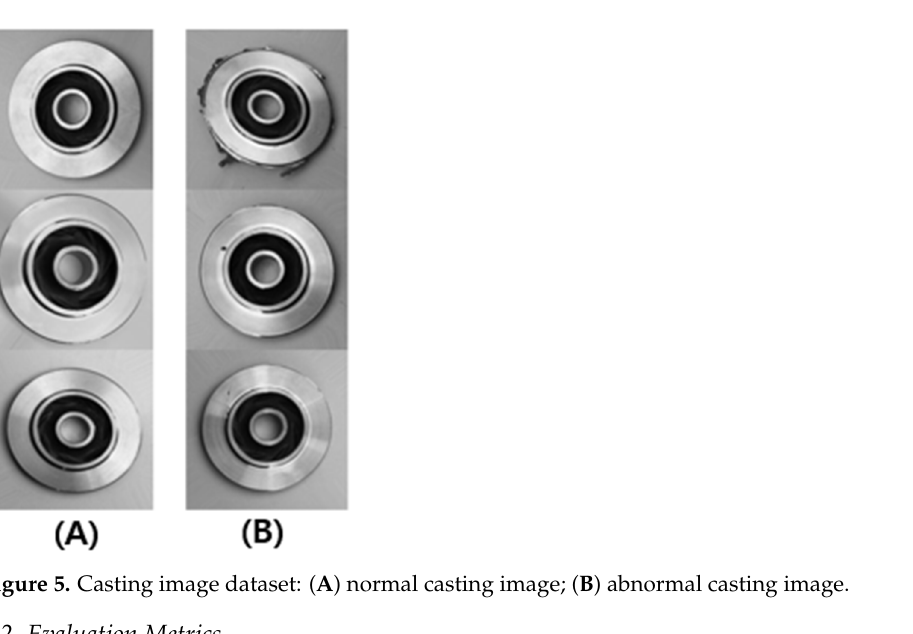
Figure 4. Bearing vibration dataset time-series images.